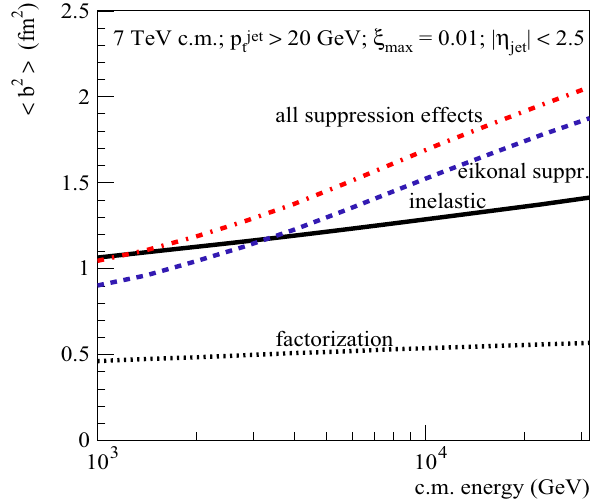
Fig. 12 Average b 2 for inelastic pp collisions (solid) and for SD dijet √ = 20 GeV/c, ξ = 0 . 01, and s = 7 TeV, p cut production for max t | η | < 2 . 5, as calculated using the different approximations: factoriza- jet tion (dotted), eikonal suppression (dashed), and all suppression effects